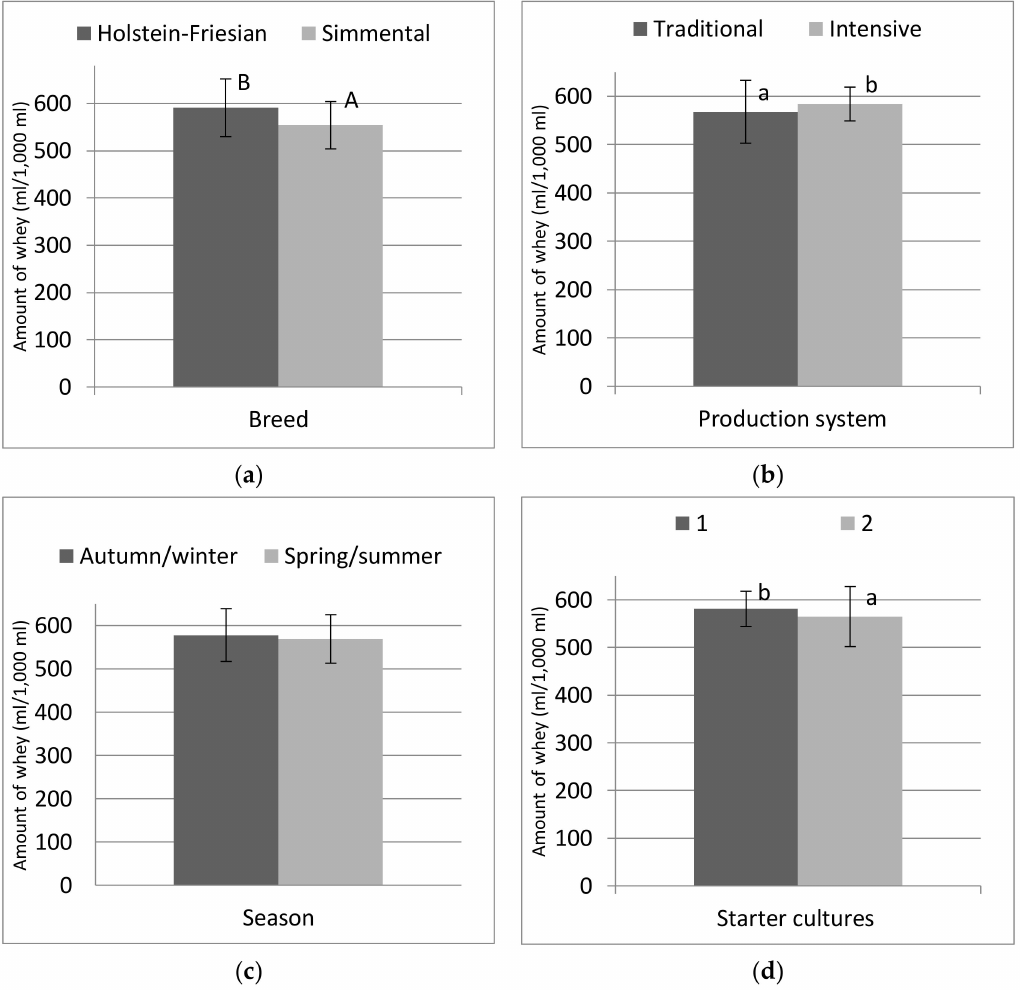
Figure 1. ( a ) The amount of whey generated, depending on the breed of cow, ( b ) milk production system, ( c ) season of production and ( d ) type of starter cultures (1—freeze-dried DVS starters; 2—traditional working starter). a, b, A, B—di ff erences within the factor; a, b—significant at p ≤ 0.05; A, B—significant at p ≤